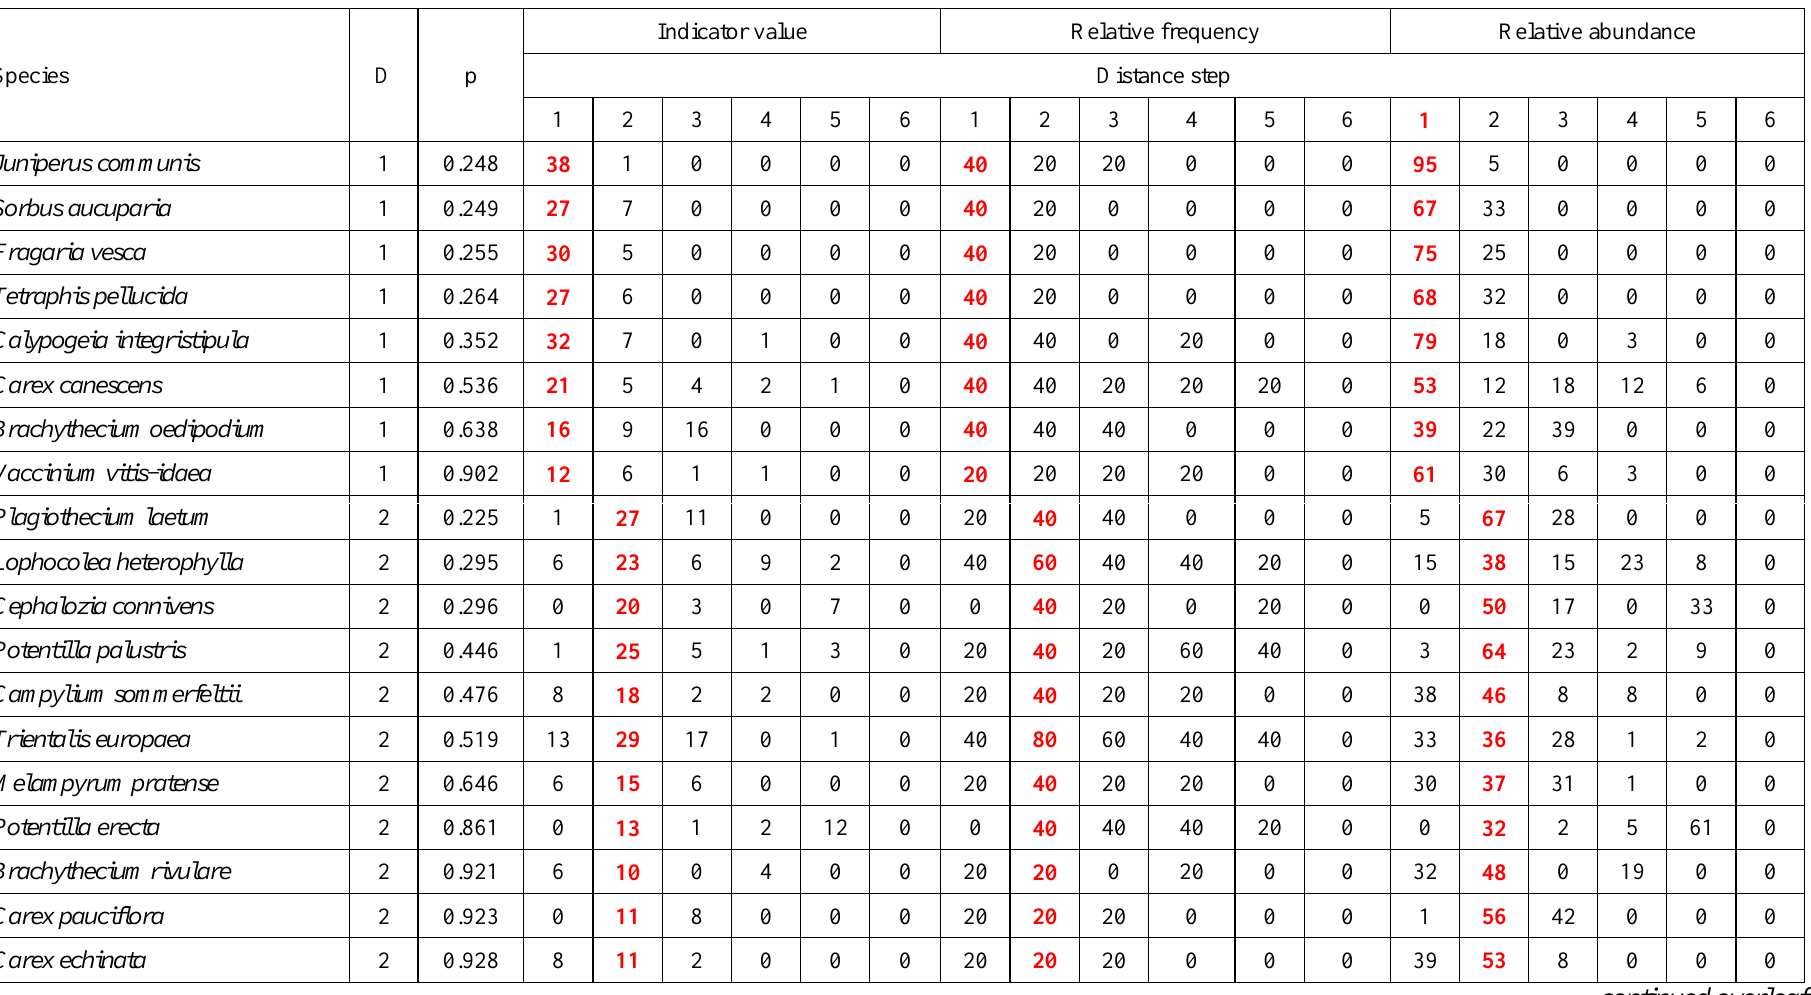
Table 2. Indicator values, relative frequency and relative abundance of transitional mire species in relation to distance from the cutoff ditch. Abbreviations: D = distance step from the cutoff ditch (1 = 5 m, 2 = 15 m, 3 = 40 m, 4 = 90 m, 5 = 190 m, 6 = 440 m), p = significance level. Indicator value Relative frequency Species D p